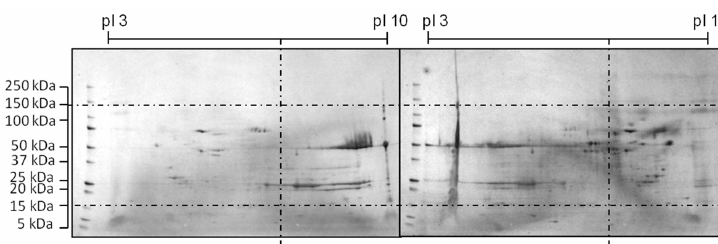
Table 3. Improved parameters by using an optimized medium according to [47].